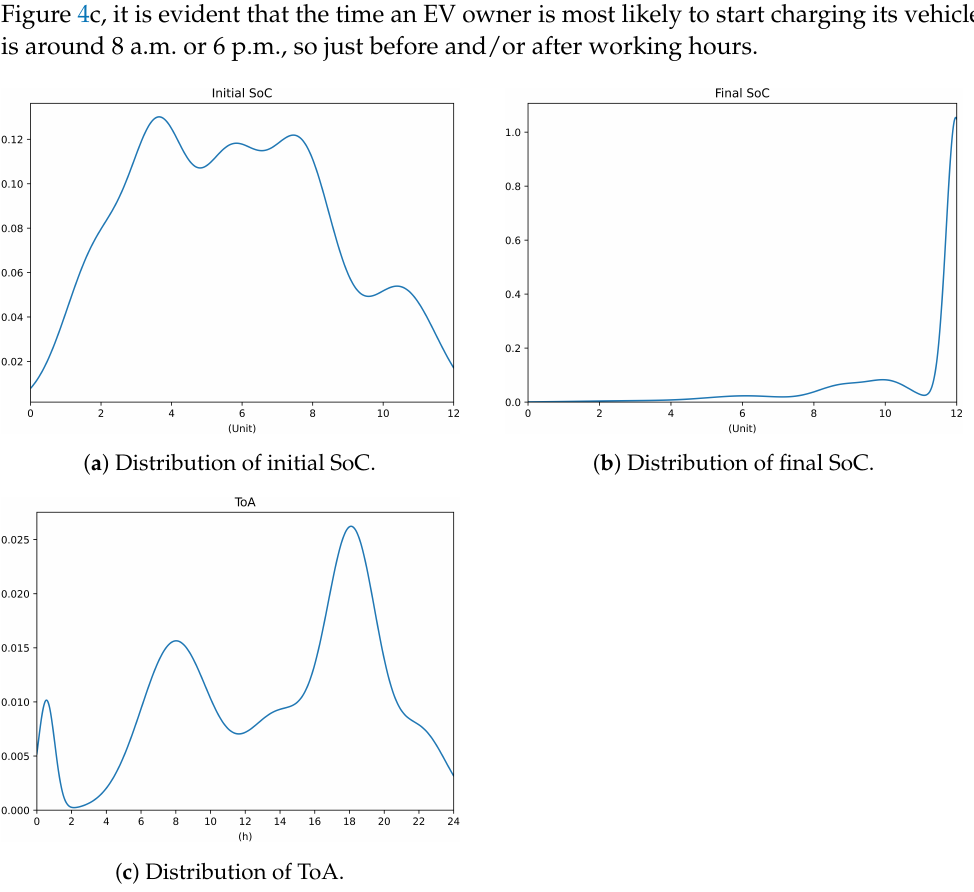
Figure 4. Distributions of initial SoC ( a ), final SoC ( b ), and ToA ( c ) considered in this